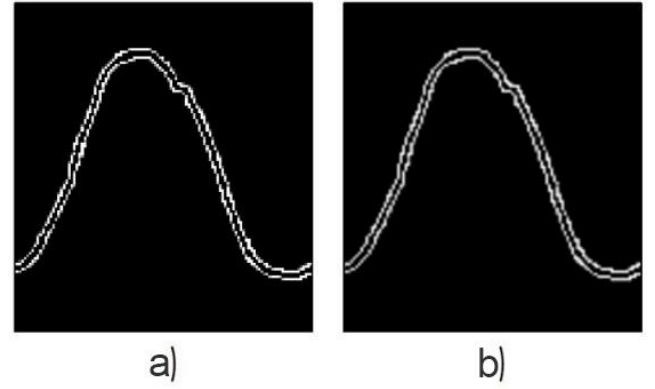
Figure 11. Initial image processing areas: a) using the first four morphological operators, b) using all